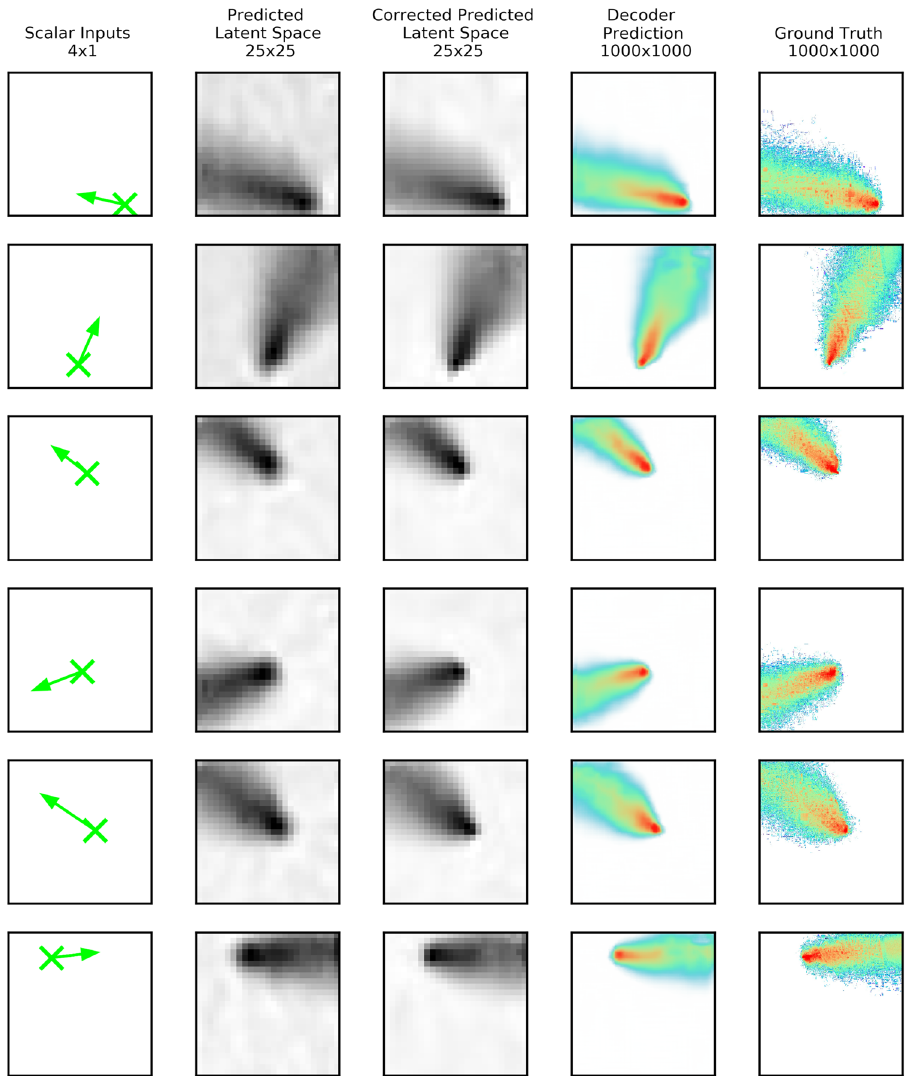
Figure 5. Images corresponding to different stages of the ABM prediction process for six randomly selected test cases shown in each row. The first column shows a schematic of the scalar inputs source location (cross), wind speed (arrow length), and wind direction (arrow orientation). The second column shows the predicted latent space using the bottleneck model. The third column shows the corrected latent space. The fourth column shows the final prediction using the decoder. Finally, the fifth column shows the ground truth. The colors of the pixels in the two rightmost columns denote the logarithm of